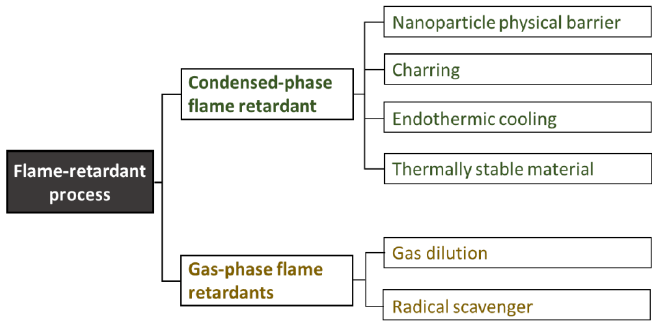
Figure 9. Classification of flame retardant additives based on process [95]. Reprinted with permission from Ref. [95]. Copyright 2018, Springer.